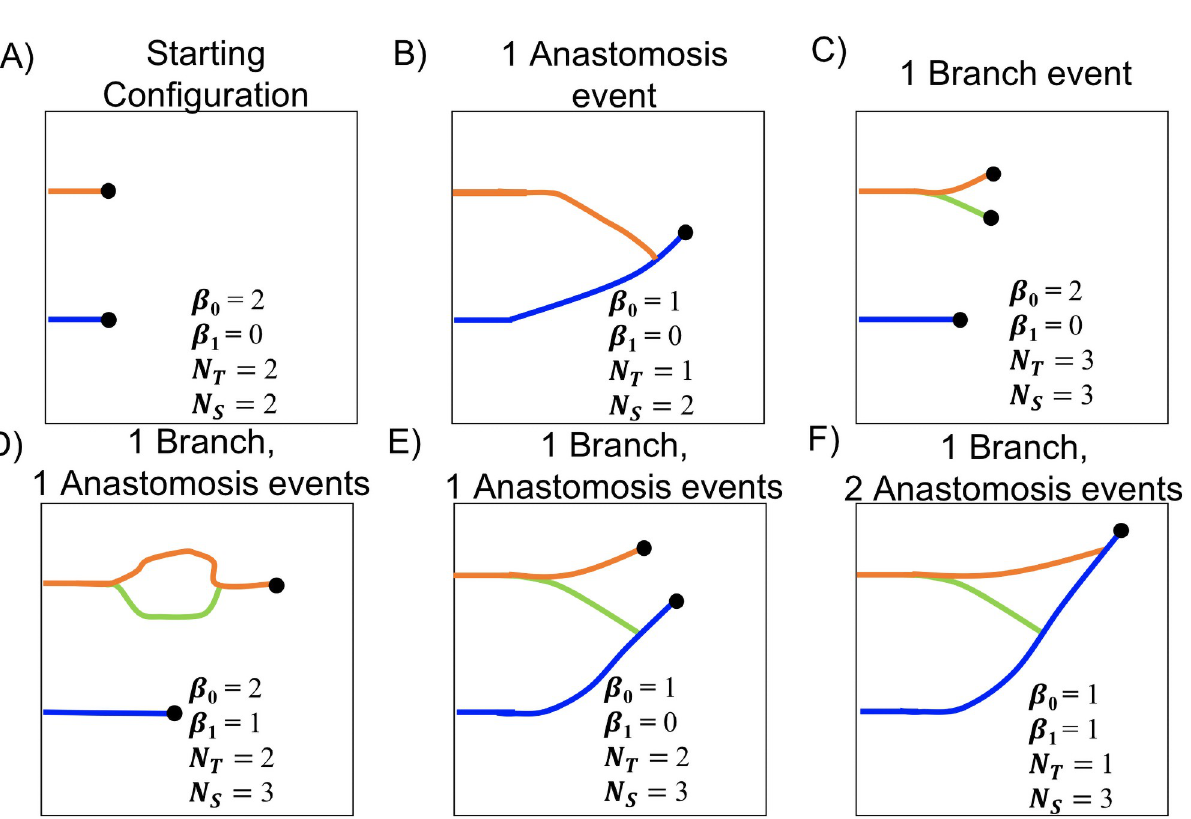
Fig 8. Standard and topological descriptors describe distinct aspects of vessel morphology. For clarity, each vessel segment is colored differently, and black dots represent active tip cells. A) The initial vessel configuration. B) A schematic showing how the vascular architecture changes after an anastomosis event. C) A schematic showing how the vascular architecture changes after a branching event. D-E) Schematics showing two ways in which vasculature can change after one anastomosis event and one branching event. F) A schematic showing how the vessels can change after one branching and two anastomosis events. (Key: β 0 , number of connected components; β 1 , number of loops; N